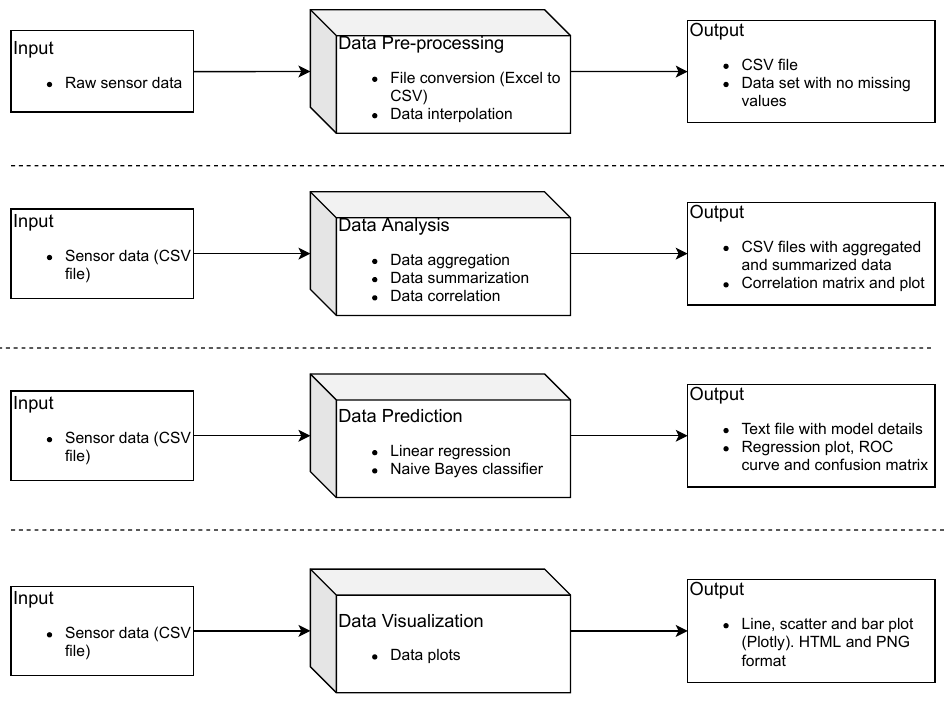
Figure 1. Vayu workflows: The toolbox supports the analysis of sensor data by including four workflows. The toolbox accepts external inputs for different workflows and produces output that is stored